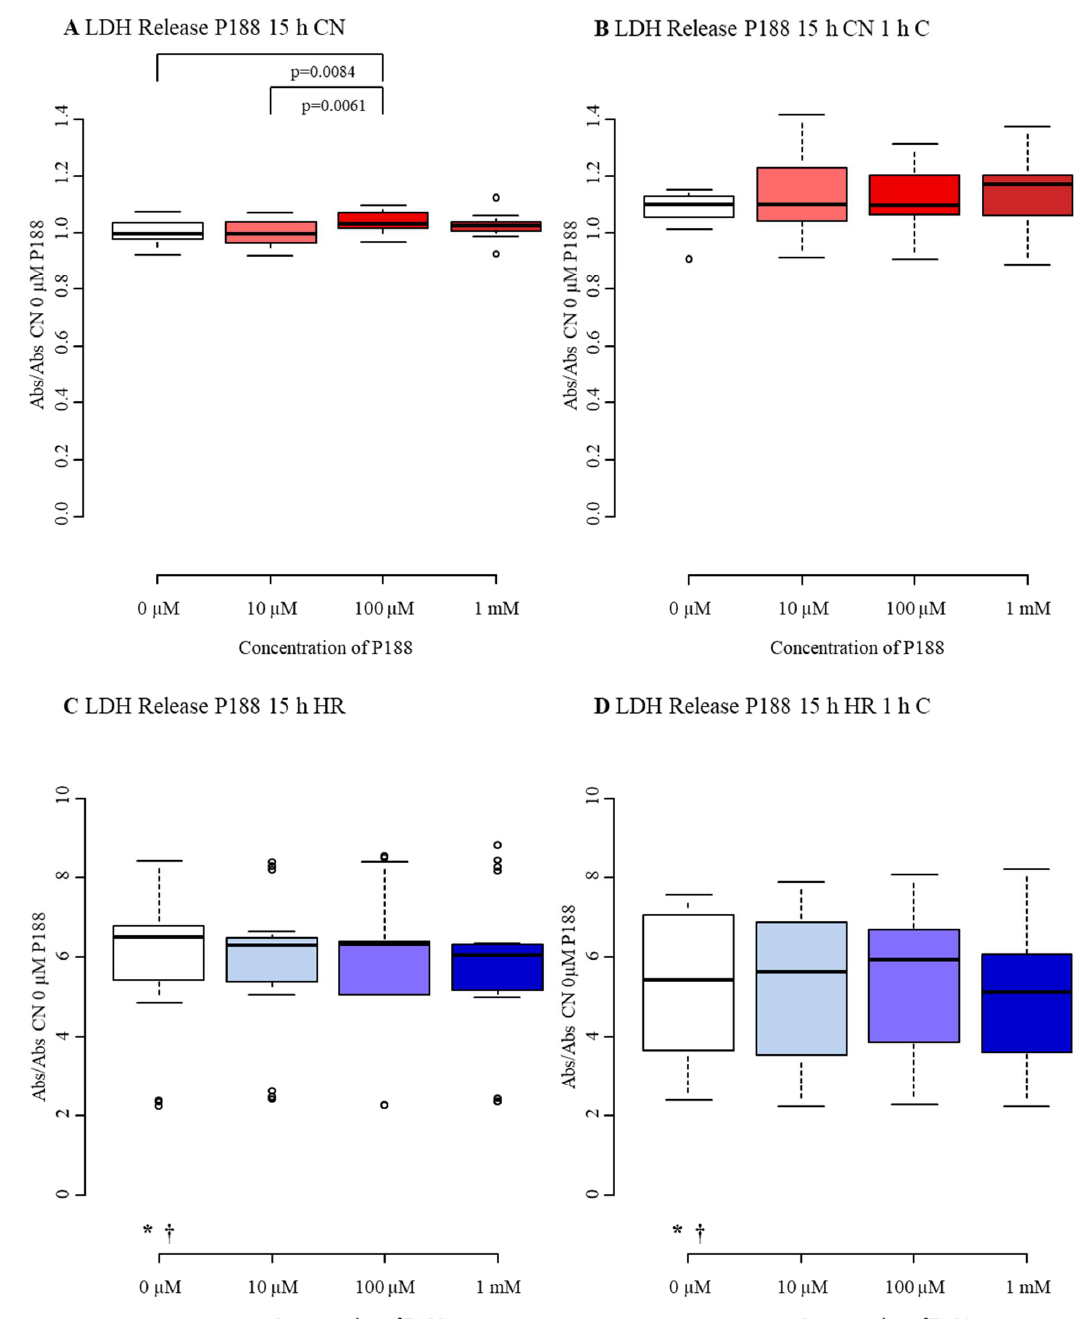
Figure A2. Cytotoxicity/membrane damage via LDH release after 15 h injury and treatment with 0 µ M, 10 µ M, 100 µ M, and 1 mM of P188. ( A ) normoxia (CN-C); ( B ) normoxia and 1 h compression (CN+C); ( C ) hypoxia (HR-C); ( D ) hypoxia and 1 h compression (HR+C). Data visualized as boxplots (median, 25th, 75th percentile, whiskers: minimum, maximum, dots: potential outliers); p < 0.05; n = 4 experiments/group. Significances between different concentrations of P188 are displayed as brackets, significances between ( A – D ) for 0 µ M P188 are represented by symbols (* vs. CN-C 0 µ M P188, † vs. CN+C 0 µ M P188). Abbreviations: Abs, absorbance; C, compression; CN, control/normoxia; h, hours; HR, hypoxia/reoxygenation; LDH, lactate dehydrogenase; mM, millimolar; µ M, micromolar; P188, Poloxamer 188. Colors: red, normoxia; blue, hypoxia/reoxygenation. The shadows of red/blue represent the different concentrations of